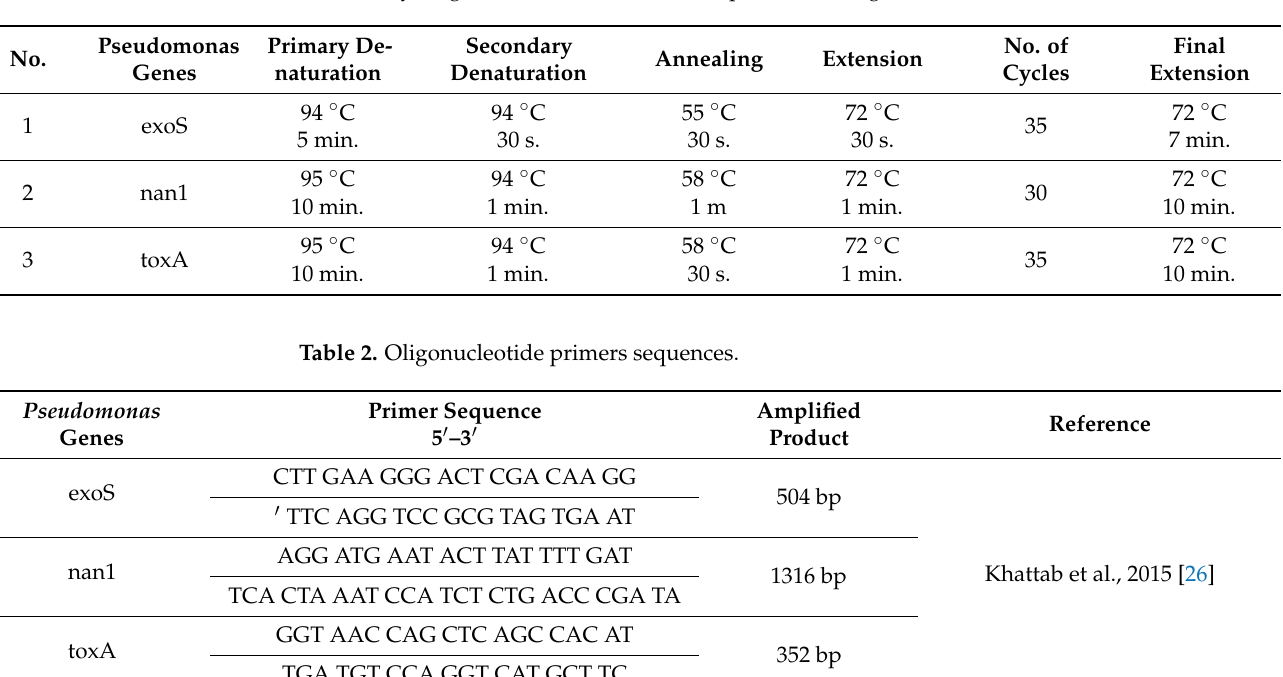
Table 1. Cycling conditions of the different primers during PCR.